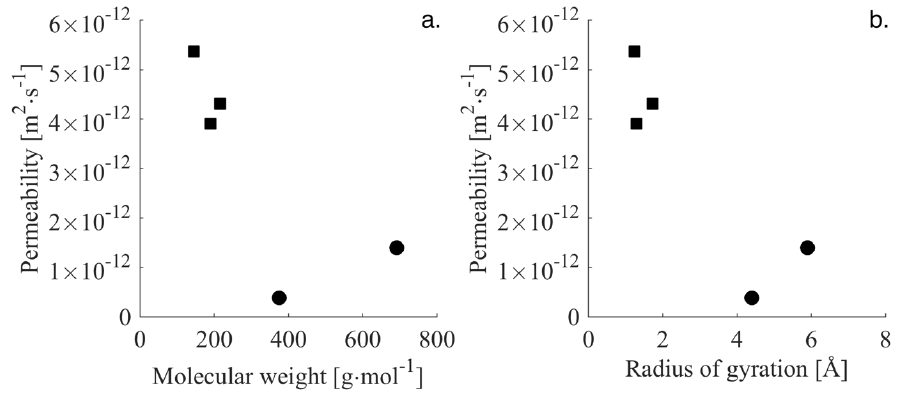
Figure 5. Permeability as a function of molecular weight ( a ) and radius of gyration ( b ). As a comparison, three previously tested pesticides are shown in ■ symbols. The two peptides are shown in ● symbols.